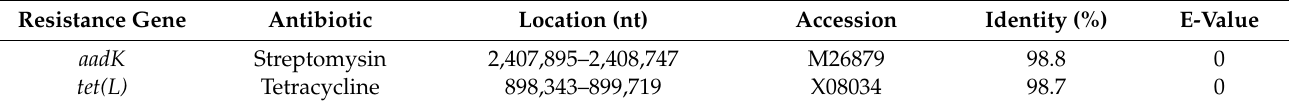
Table 5. Antibiotic resistance genes detected in B . subtilis IDCC1101 using ResFinder.